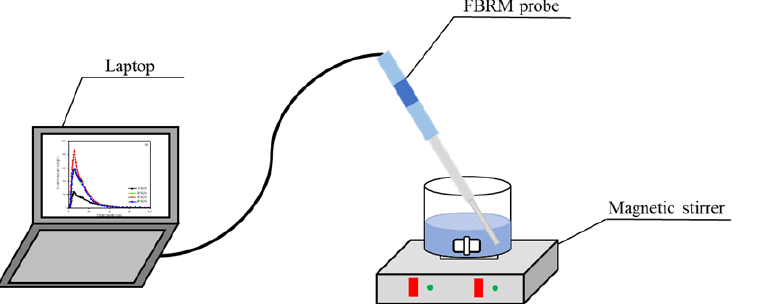
Figure 5. Diagram of the FBRM test system.